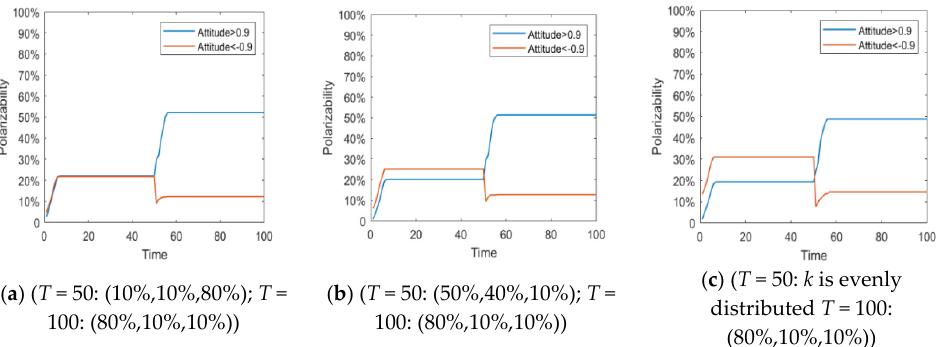
Figure 17. Curve of group attitude polarization with different conservation proportion at different times. ( a ) ( T = 50: (10%,10%,80%); T = 100: (80%,10%,10%)); ( b ) ( T = 50: (50%,40%,10%); T = 100: (80%,10%,10%)); ( c ) ( T = 50: k is evenly distributed T = 100: (80%,10%,10%)).